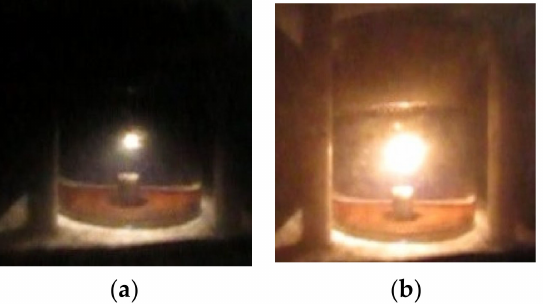
Figure 3. Two successive frames of microwave discharge in engine oil obtained in the installation with quarter wavelength antenna described in [29–31] (shooting speed is 240 frames per second, time interval between figures ( a ) and ( b ) is of 4 ms).